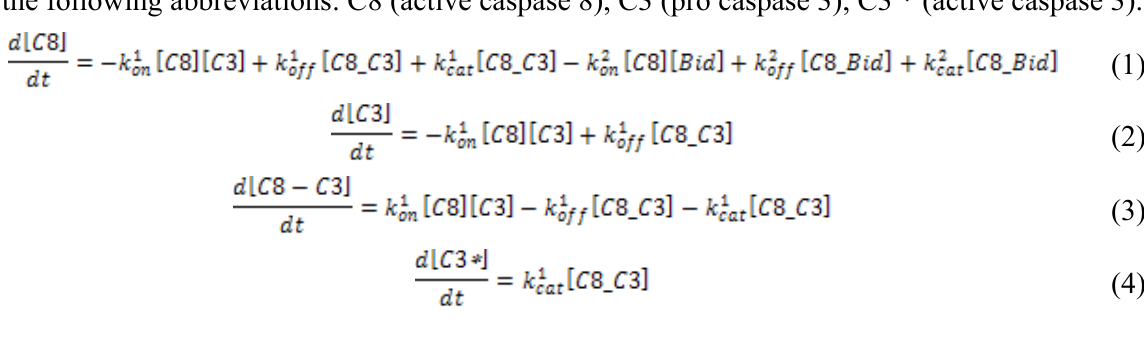
Probabilistic parameters used in the Monte Carlo simulation